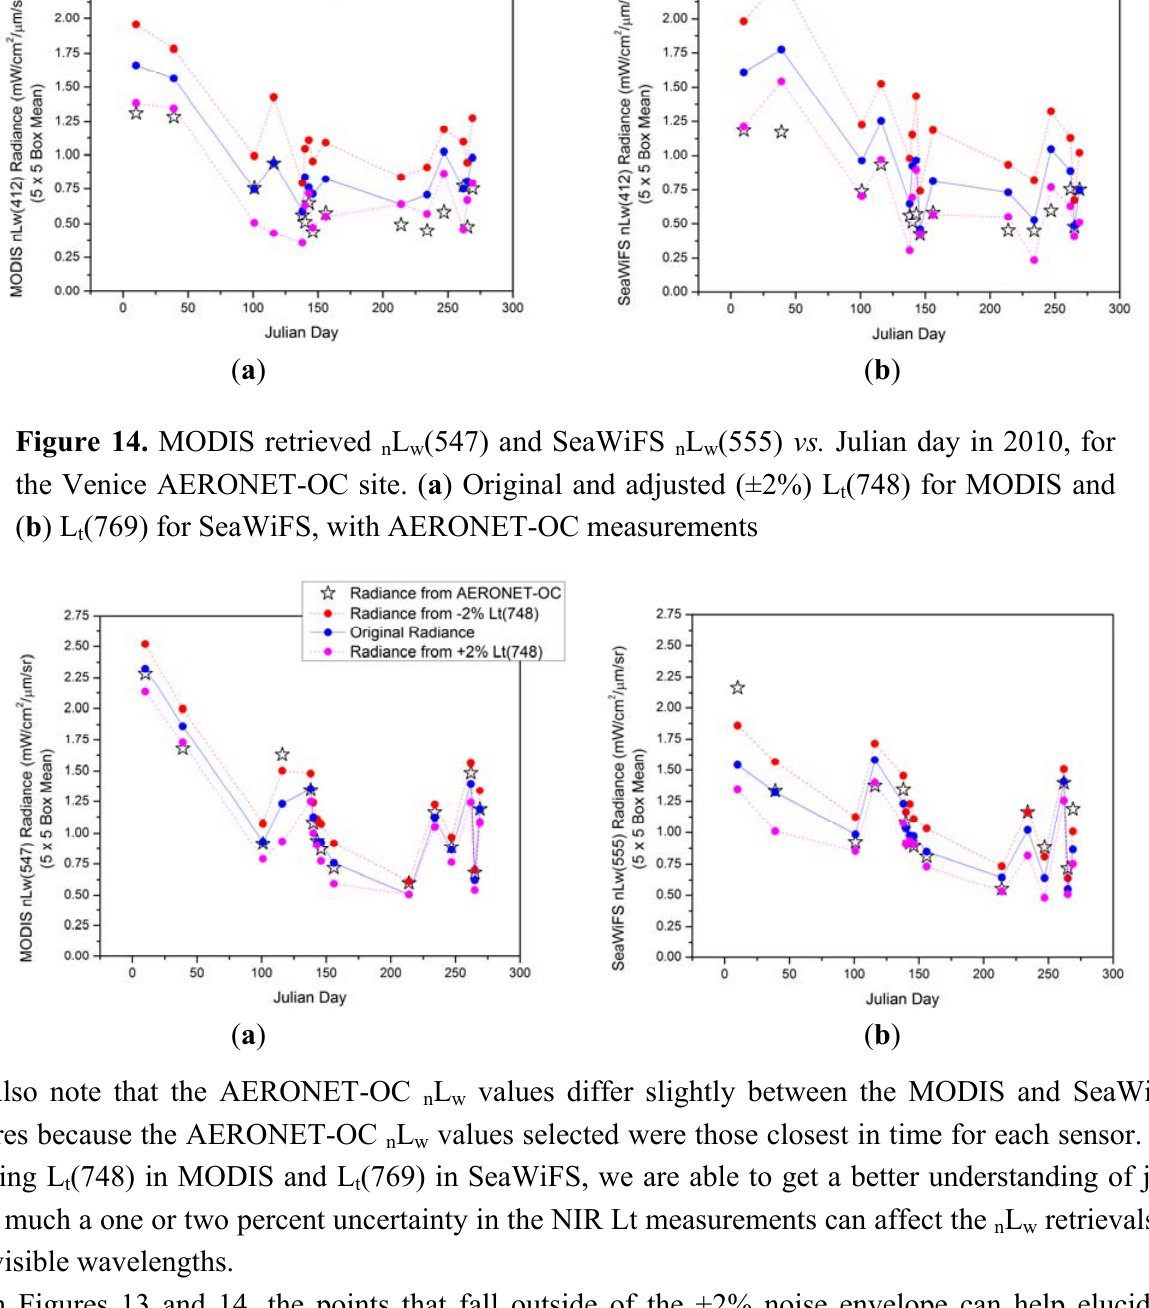
Figure 13. MODIS and SeaWiFS retrieved AERONET-OC site. ( a ) Original and adjusted (±2%) L for SeaWiFS, star symbols indicate AEROENT-OC measurements.